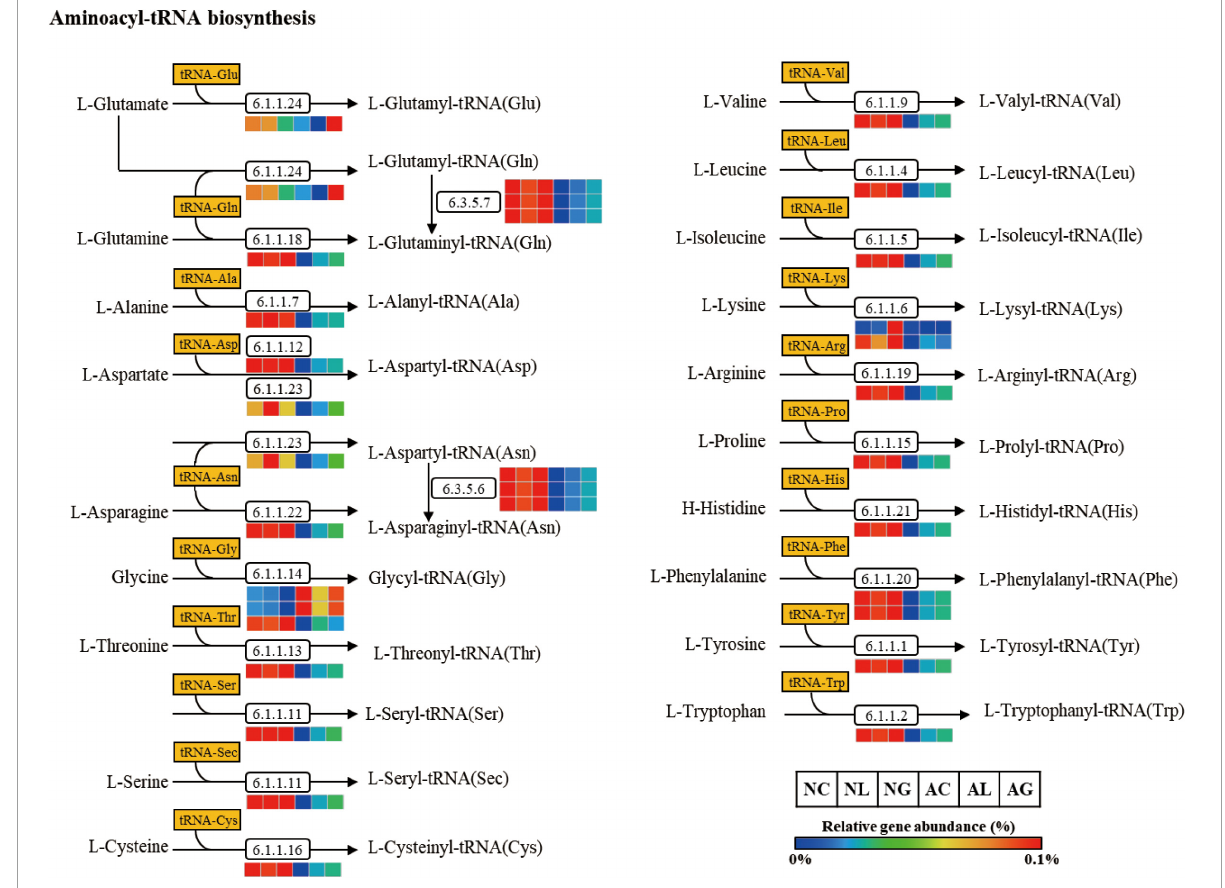
FIGURE8 Aminoacyl-tRNA biosynthesis pathway predicted from an OTU table using the PICRUSt algorithm. The pathway was predicted making use of references from the KEGG BRITE functional database, modified from http://www.genome.jp/kegg/pathway/map/map00970.html. NC, normal diet group; NL, normal diet and Lactiplantibacillus ( Lp .) plantarum DSR J266 + Levilactobacillus ( Lv .) brevis DSR J266 group; NG, normal diet and Lacticaseibacillus ( Lb .) rhamnosus GG group; AC, alcohol diet group; AL, alcohol diet and Lp . plantarum DSR J266 + Lv . brevis DSR J301 group; AG, alcohol diet and Lb. rhamnosus GG group; OUT, operational taxonomic